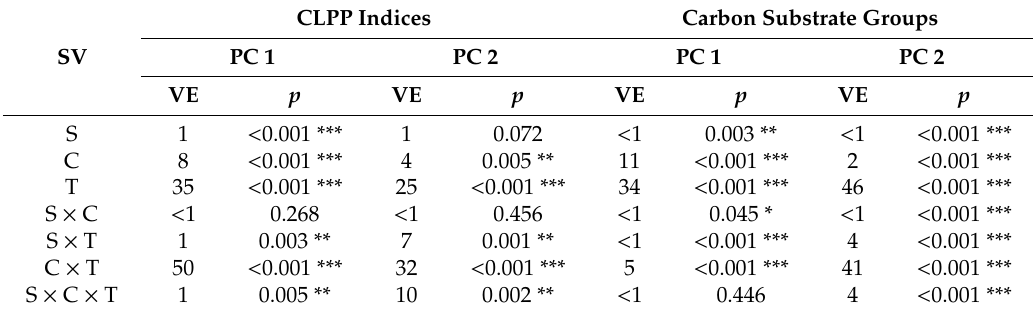
Table 3. Results of the three-way MANOVA for the PC 1 and PC 2 based on the CLPP indices and carbon substrate